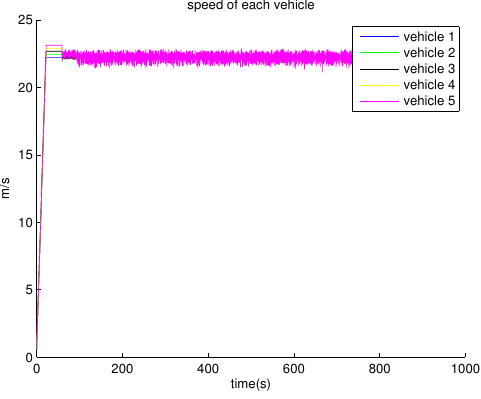
Figure 4. γ = 1.01 is used. The speed of every truck converges to the speed of the leader as time goes on. Due to the noise in the system, the truck speed is also